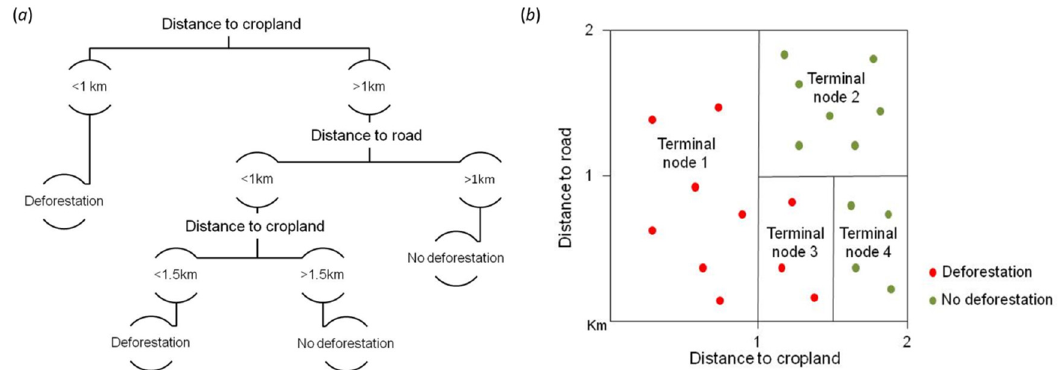
Figure 1. In this illustrative example land cover is predicted based on distance from cropland and road. Both pictures display the same decision problem using different representation systems: ( a ) shows the classification tree with three internal nodes and four terminal nodes; ( b ) shows the partition of the two ‐ dimensional predictor space. In ( b ) the regions are entirely deforested or forested, a situation that is quite unusual in real ‐ world models.